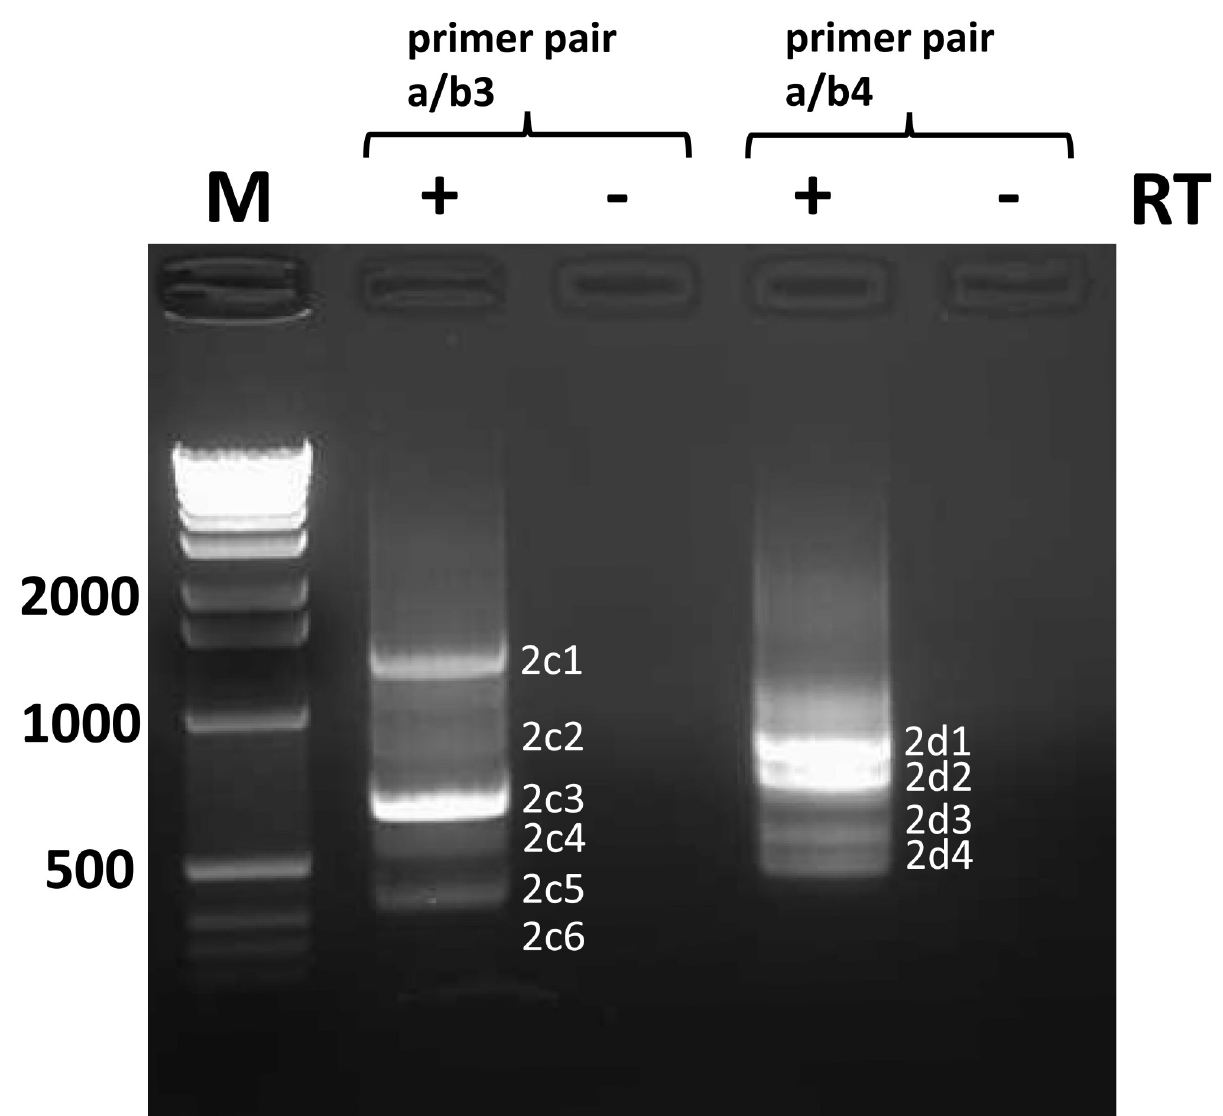
Fig 9. Identification of trailer copyback DVGs in virus #2 by RT-PCR using primer pairs a/b3 and a/b4. RNA extracted from virus #2 was reverse transcribed using primer a and cDNA was amplified with primer pairs a/b3 and a/b4. See materials and methods and Fig 8 for further information.